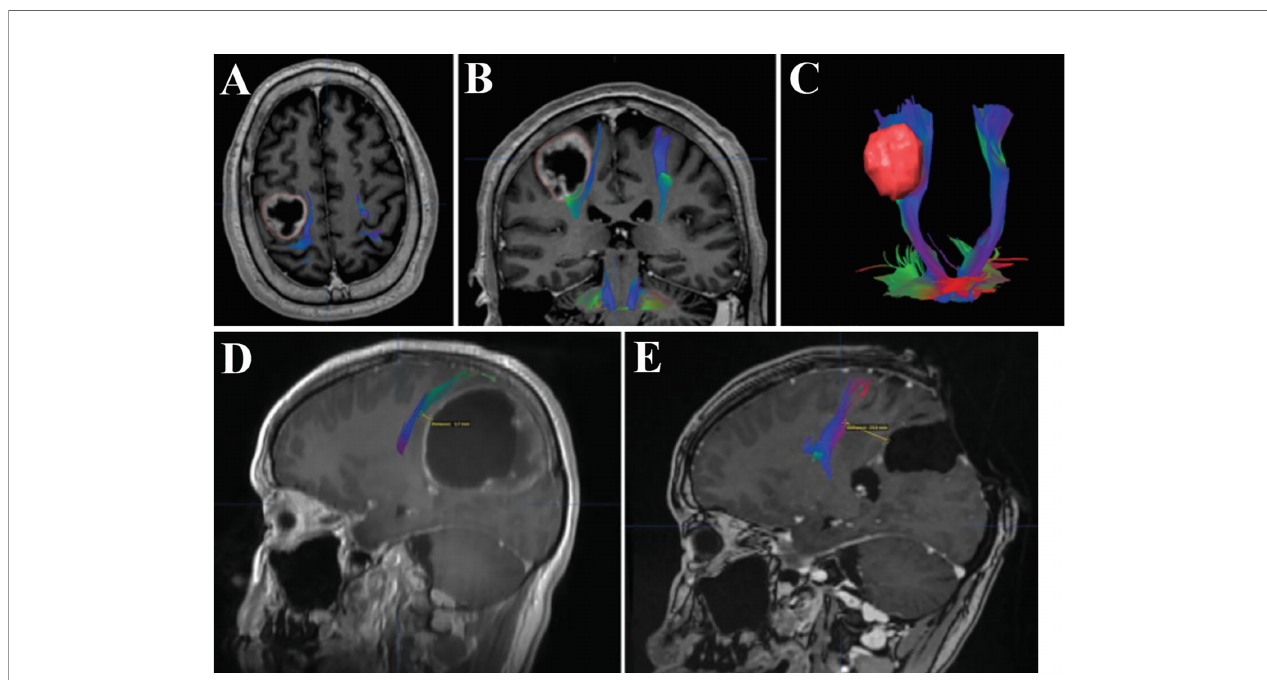
FIGURE 2 | Merged DTI sequence and contrast T1-weighted MRI revealing the proximity between BM and the CST. A cystic lesion with peripheral contrast enhancement allocated in the perirolandic region was depicted in the axial (A) and coronal (B) planes. The proximity was noted between the deep surface of the tumor and the descending fi bers of the CST (B) . The 3D reconstruction of the CST and volumetric reconstruction of the lesion showed the distortion of the motor pathways (C) . Total removal of another large cystic tumor which signi fi cantly displaced the CST (D) was con fi rmed by postoperative MRI (E) . Notably, the distance between surgical cavity and the CST increased from 5.7 to 24.9 mm, suggesting the effect of initial deformation accompanied by intraoperative brain shift. DTI, diffusion tensor imaging; MRI, magnetic resonance imaging; BM, bran metastases; CST, corticospinal tract. (A – C) Modi fi ed from Sanmillan et al. (4). (D, E) Modi fi ed from Krivosheya et al.